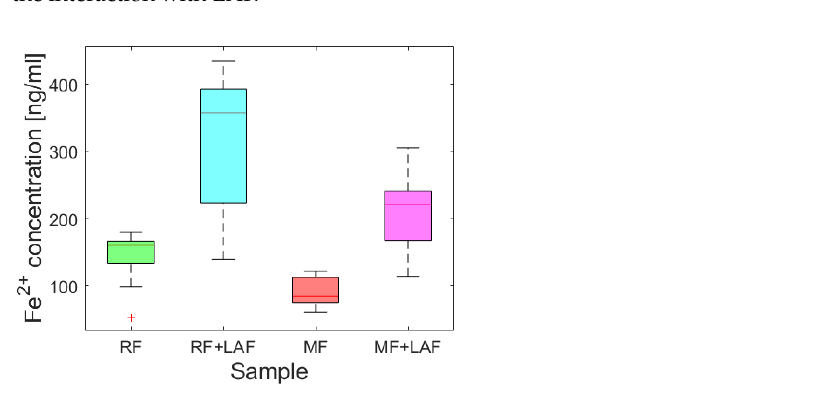
Figure 6. Median of ferrous ions released from the ferritin derivatives themselves and during interaction with LAF in 11 days.